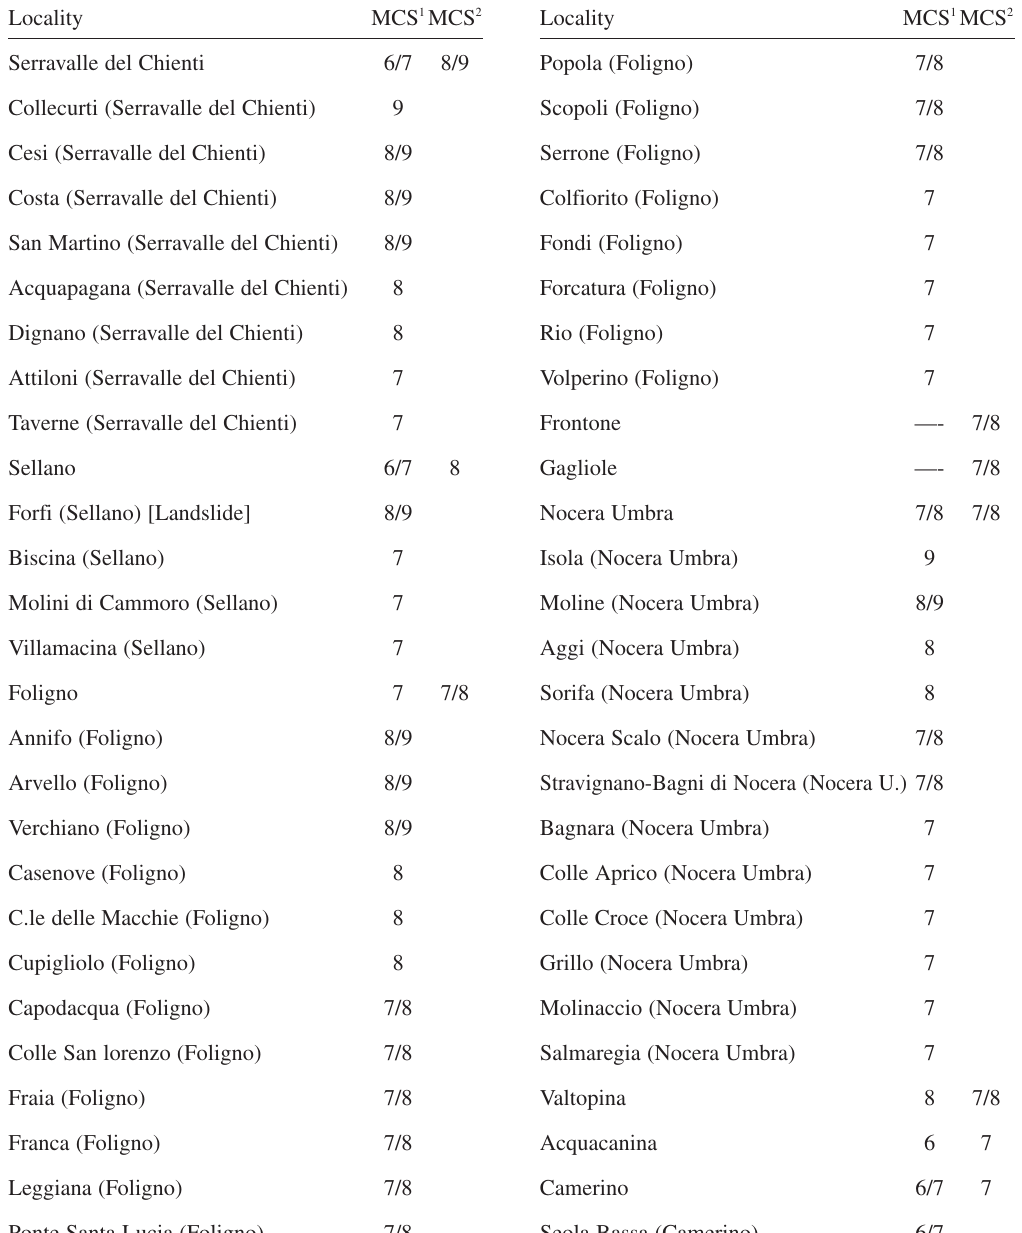
Table I. Comparison between the table of intensities (only damaged localities) for the 26 September 1997 earthquake, according to Monachesi et al. (1997; update 2 October 1997, column 1) and «Bollettino Macrosis- mico» (column